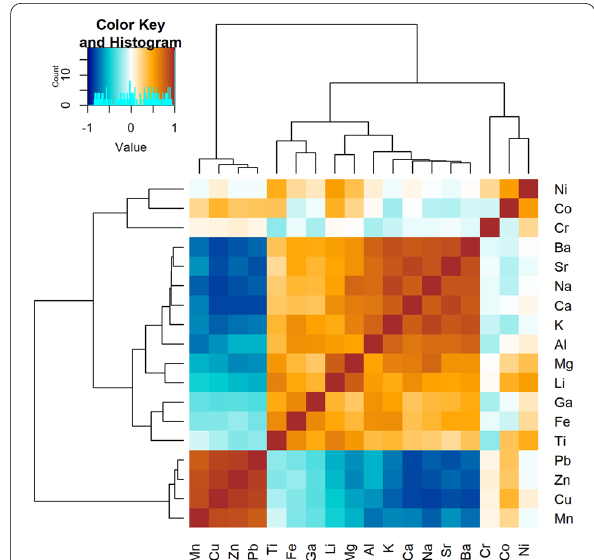
Fig. 7 Heatmap of correlation coefficients based on the symmetric coordinates for the bulk sediment. Blue colors indicate negative and brown and red colors indicate positive correlations. The elements were sorted based on the cluster analysis as suggested by Reimann et al. (2017). The cluster of Cu, Zn, and Pb in the lower left indicates that these elements could share the same